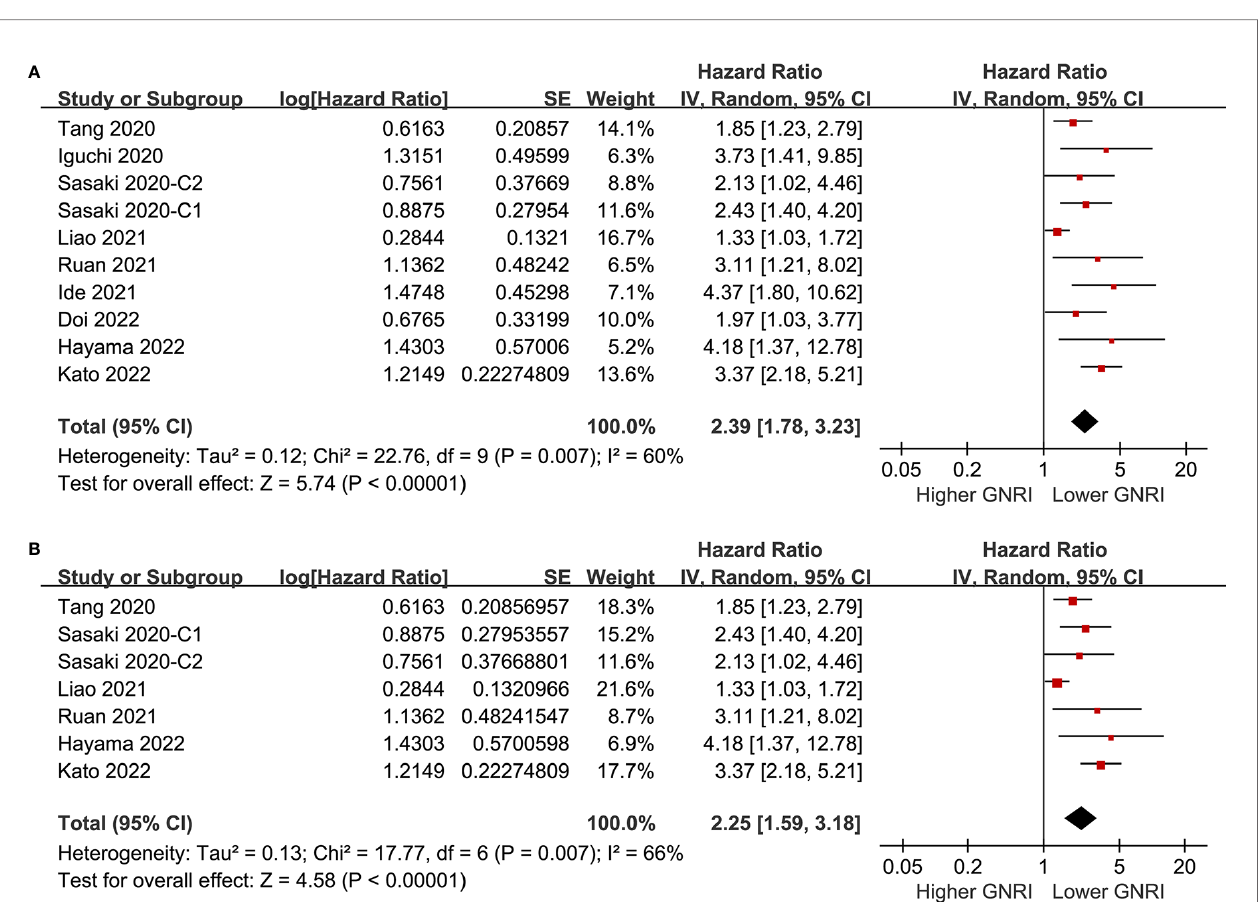
FIGURE 2 | Forest plots for the meta-analysis regarding the association between GNRI and OS in patients with CRC; (A) overall meta-analysis; and (B) sensitivity analysis limited to the elderly